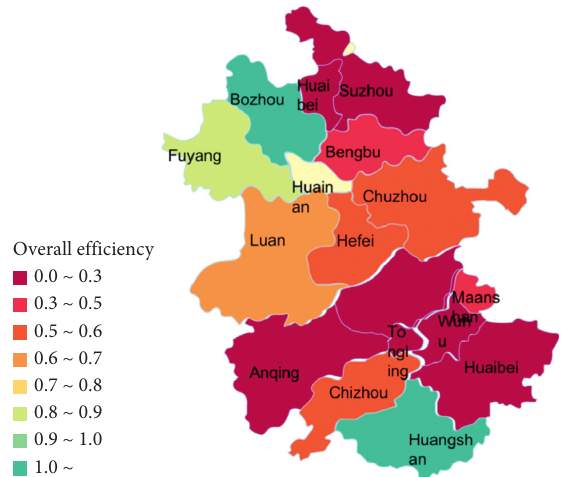
Figure 3: Overall efficiency 2011.